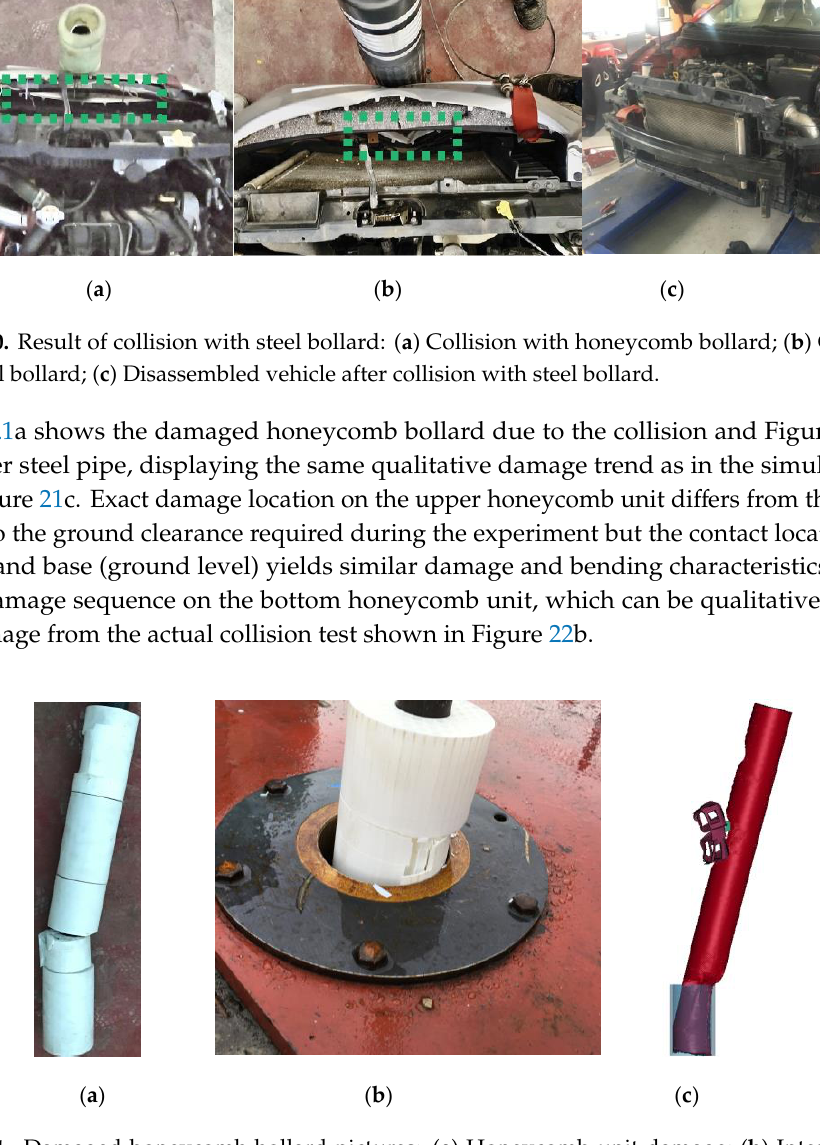
Figure 19. Acceleration of front bumper frame with gyro sensor and numerical result.